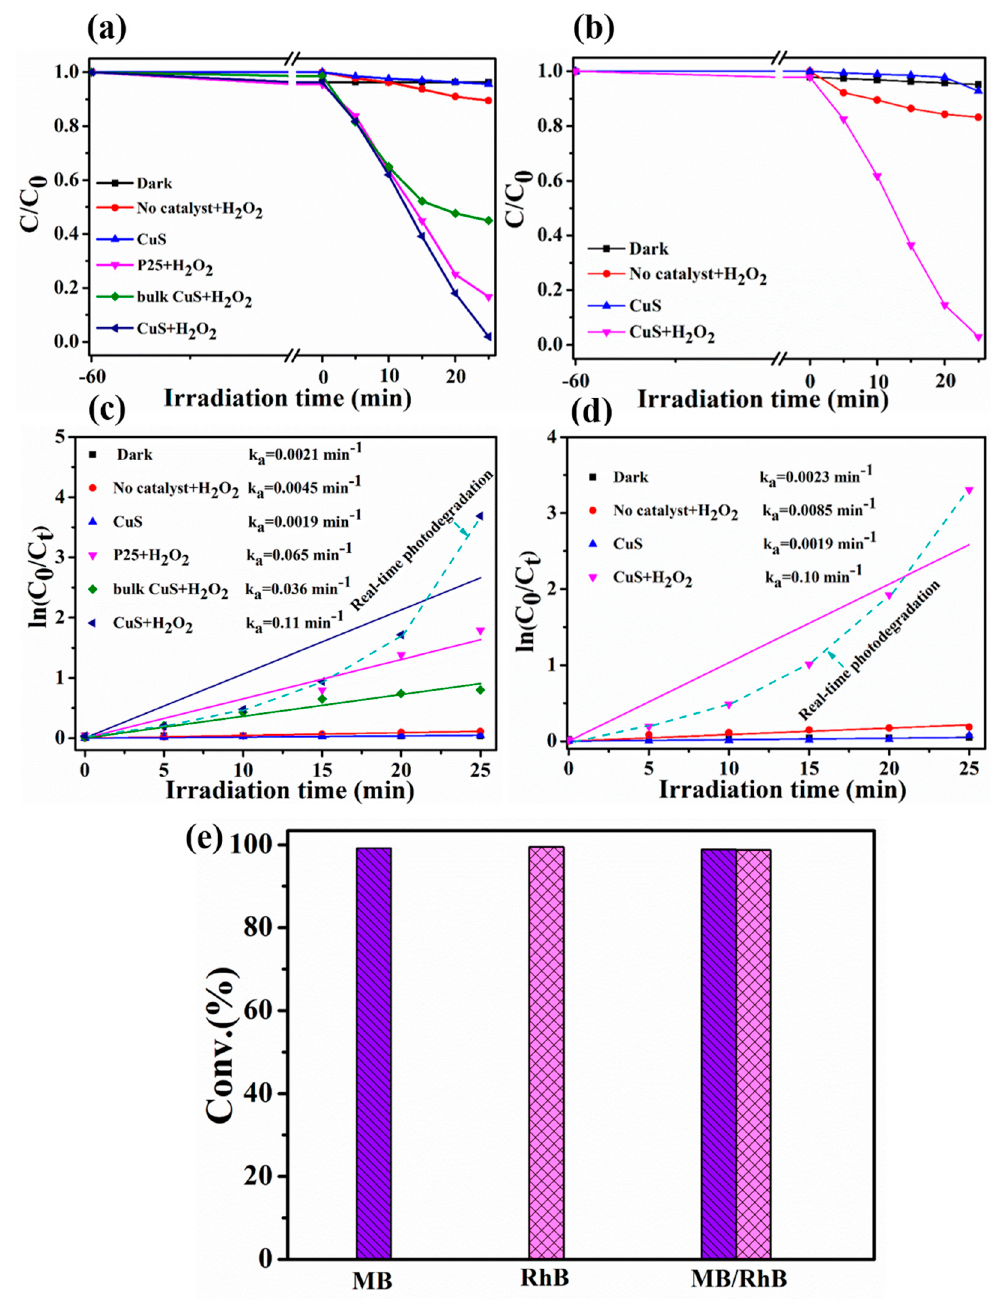
Figure 4. ( a ) Photocatalytic degradation of RhB and ( b ) MB under different conditions; ( c ) kinetics of RhB and ( d ) MB photocatalytic degradation over different catalysts; ( e ) simultaneous photocatalytic degradation of MB and RhB over CuS under identical experimental conditions (Reaction conditions: 0.05 g of photocatalyst, 40 mL of 10 mg L − 1 dye solutions, 40 μ L of H 2 O 2 , pH 4, 25 min of reaction time, 30 °C.).